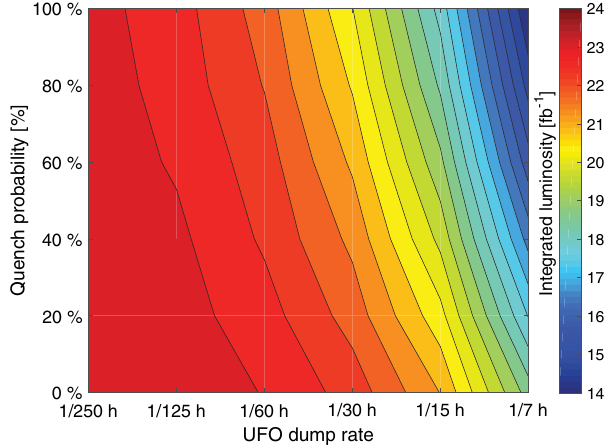
FIG. 14. Sensitivity analysis of luminosity production to UFO dump rate and quench probability, based on LHC 2012 opera- tional data. Quench probability is the probability of a quench to occur in each UFO